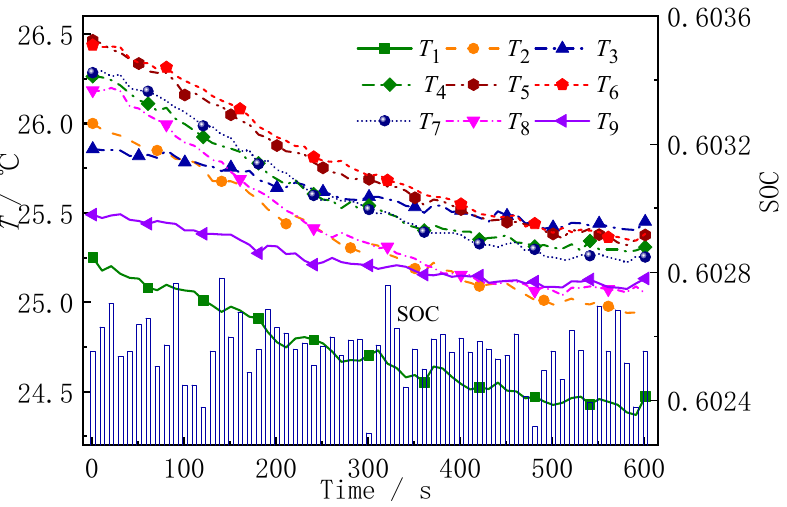
Figure 8. Time evolution of the battery module temperature during the US06 test; the pump operating frequency was 30 Hz.